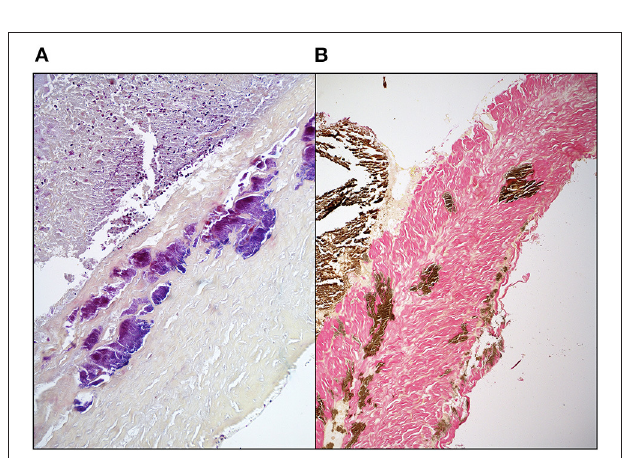
FIGURE 5 | Suspected colocalization of areas of Gram + bacterial contamination of GA-fixed bovine pericardial tissue and mineralization in a stented mitral valve replacement bioprosthesis retrieved after 112 days (A) Brown & Brenn stain (B) Von Kossa & Van Gieson stain.